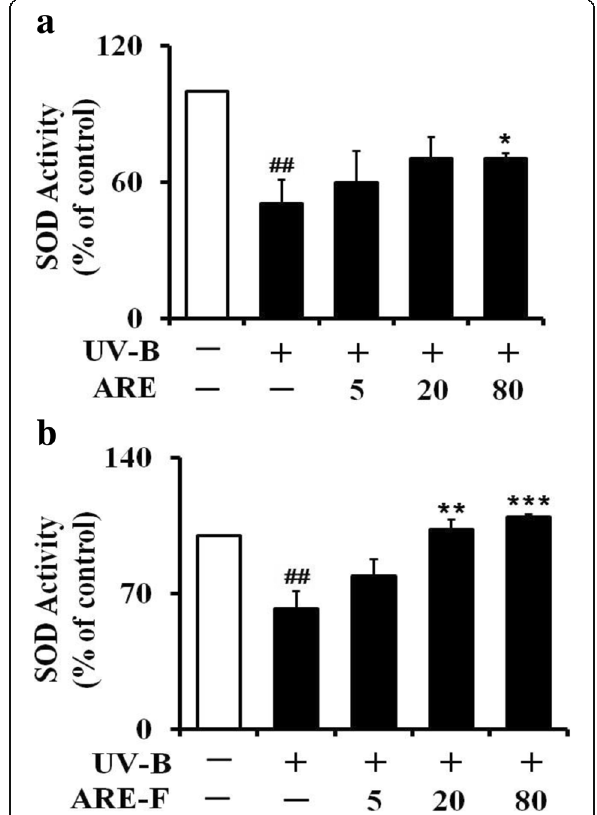
Fig. 5 Enhancing effects of ARE ( a ) and ARE-F ( b ) on the total SOD activity attenuation in HaCaT keratinocytes under UV-B irradiation. HaCaT cells were subjected to the varying concentrations (0, 5, 20 and 80 μ g/mL) of ARE ( a ) and ARE-F ( b ) for 1 h before the irradiation. The total SOD activity in the cellular lysates, expressed as a percentage (%) of the corresponding non-irradiated control, was determined using a spectrophotometric assay. ## P < 0.01 versus the non-irradiated control. * P < 0.05; ** P < 0.01; *** P < 0.001 versus the non-treated control (UV-B irradiation alone)